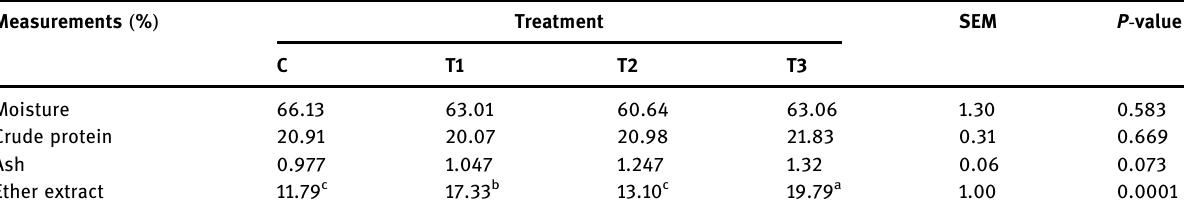
Table 14: E ff ect of treatment on the meat chemical composition of growing Najdi lambs Measurements ( % )